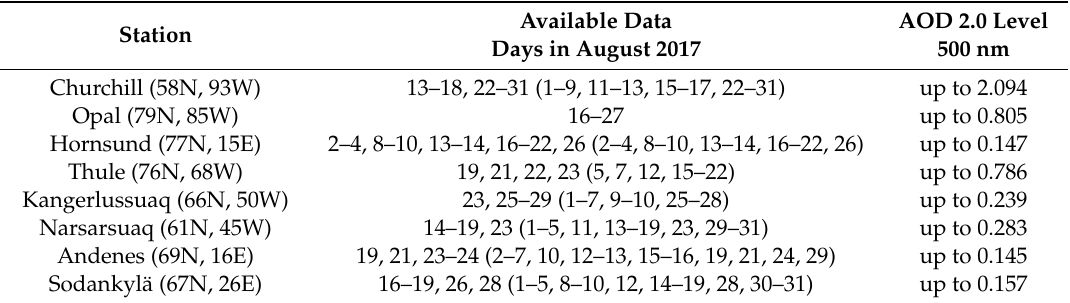
Table 1. AERONET stations located near or beyond the polar circle with August 2017 daily average aerosol optical depth (AOD)